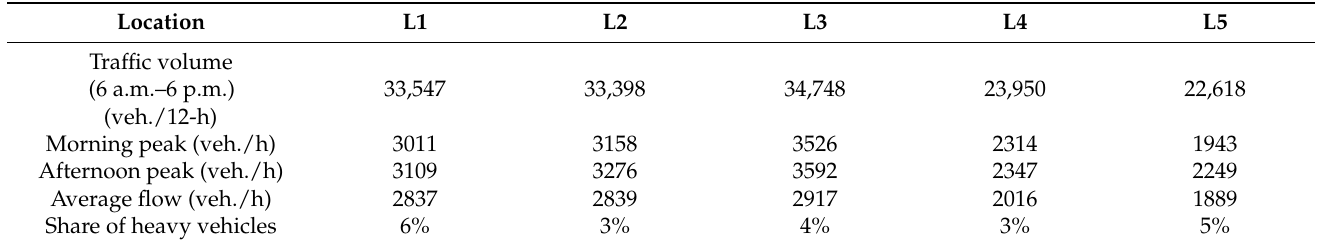
Table 6. Traffic characteristics at individual locations (data from the city road administration).